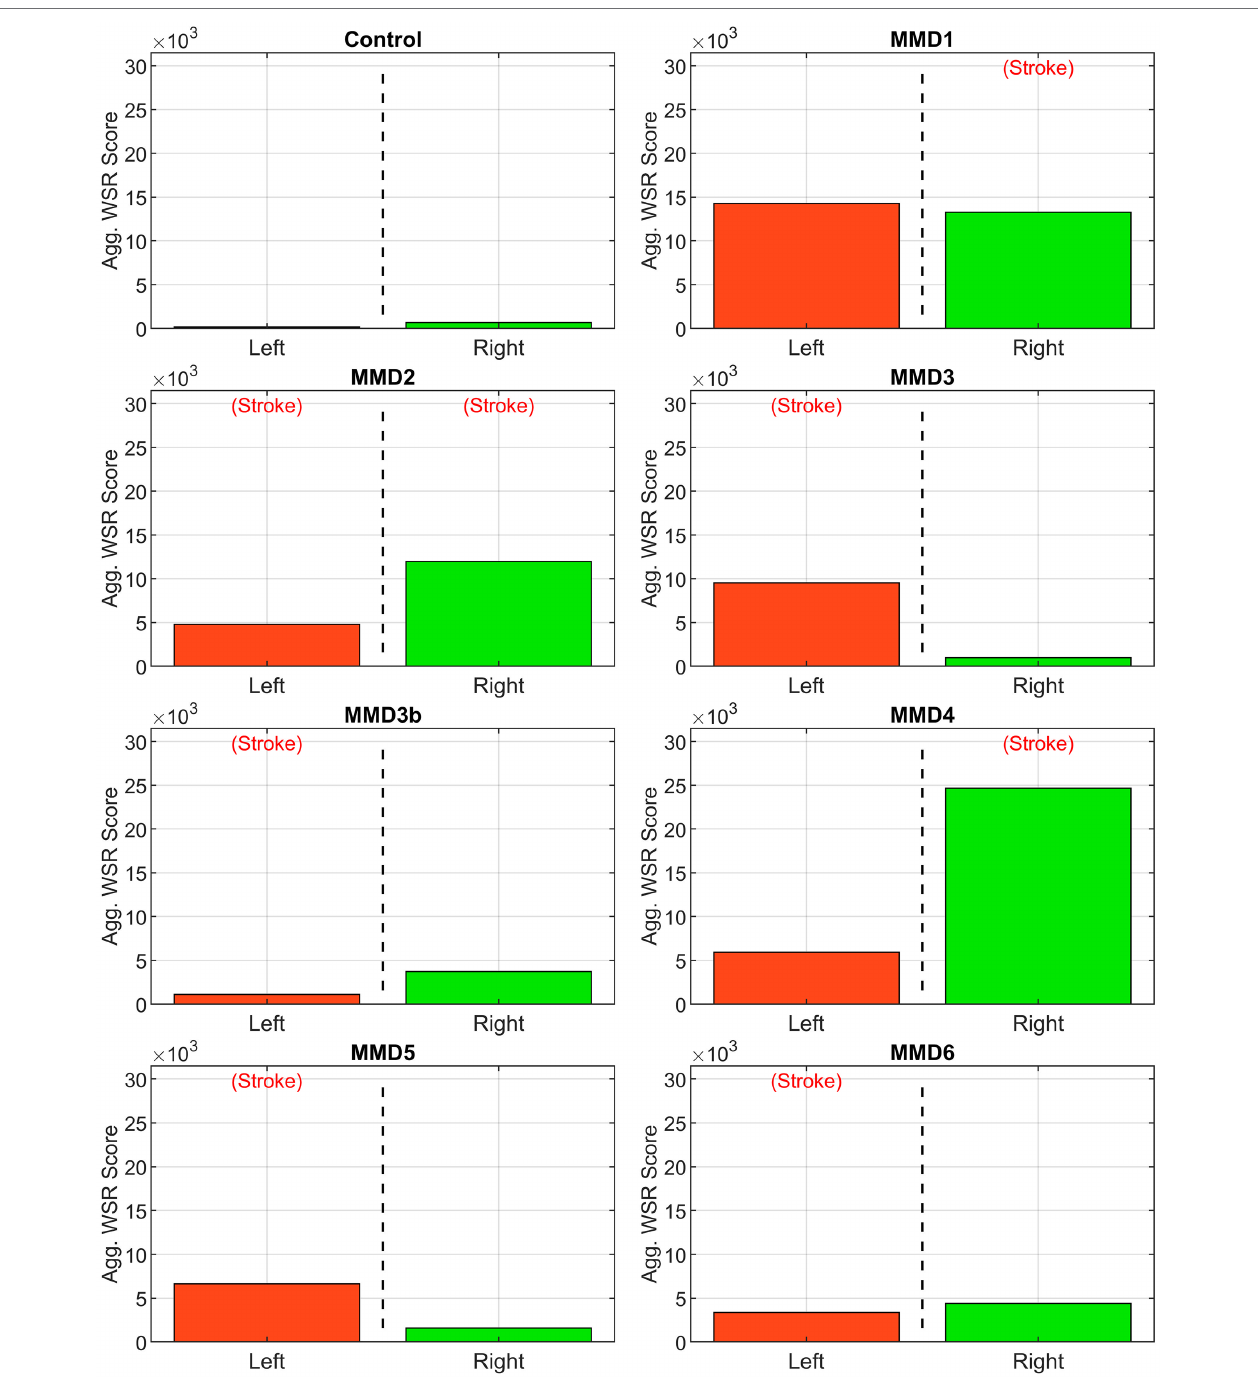
FIGURE 7 | Aggregate WSR score. Area under the WSR distribution curves from Figure 4 aggregated by side for the control subject and the six patients we studied as: MMD1, MMD2, MMD3 and MMD3b, MMD4, MMD5, and MMD6. For each patient, the values shown in Figure 5 are added. The label (Stroke) indicates the side of primary stroke